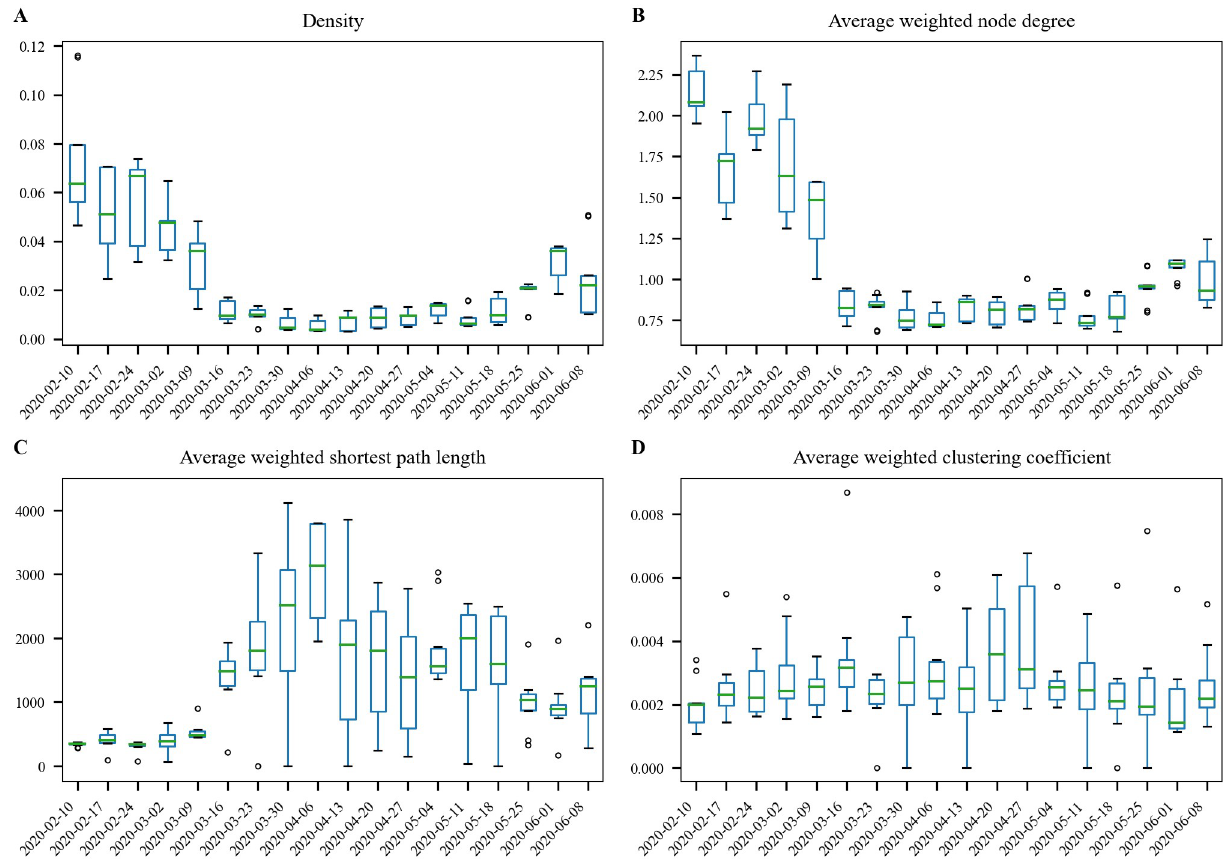
Fig 5. Network metrics between February and June. A: Density. B: Average node degree weighted by κ i , j . C: Average shortest path length weighted by 1/ κ i , j . D: Clustering coefficient weighted by κ i , j . Each date includes 10 realizations of the